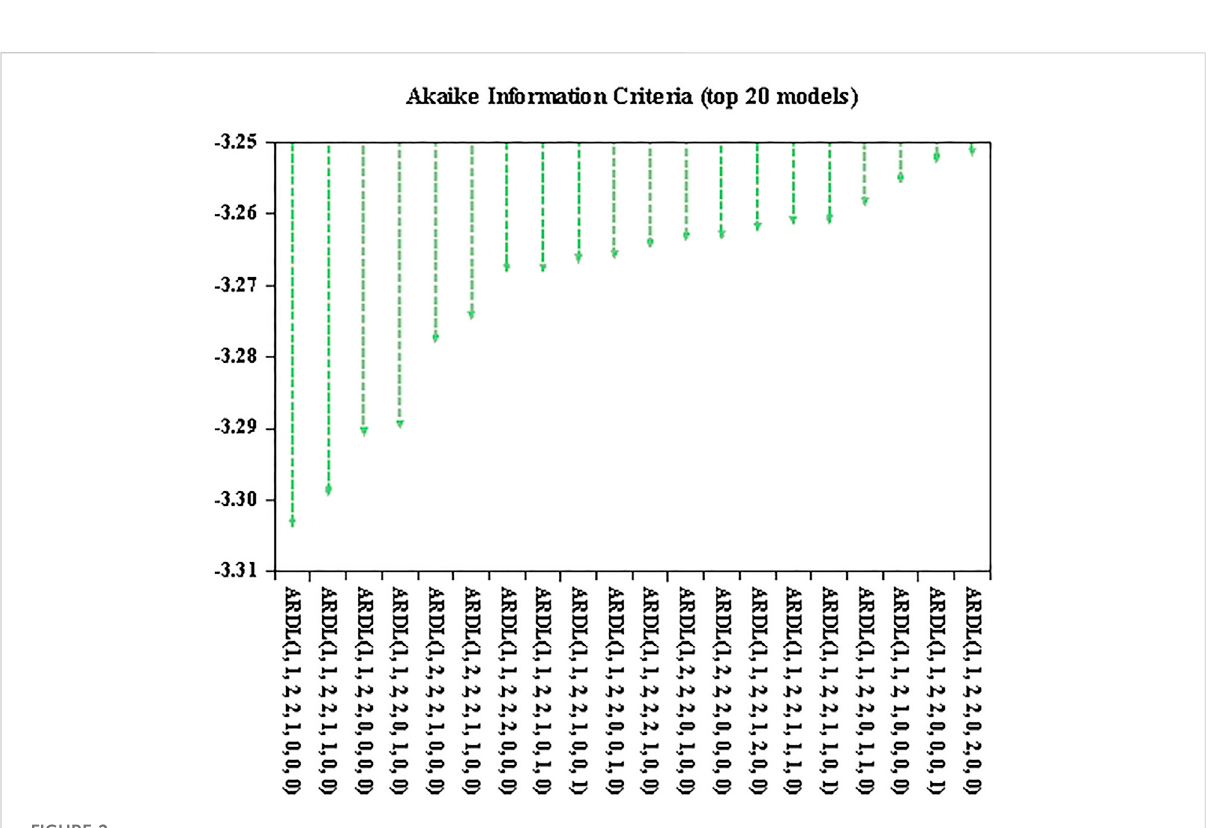
FIGURE 2 ARDL model selection